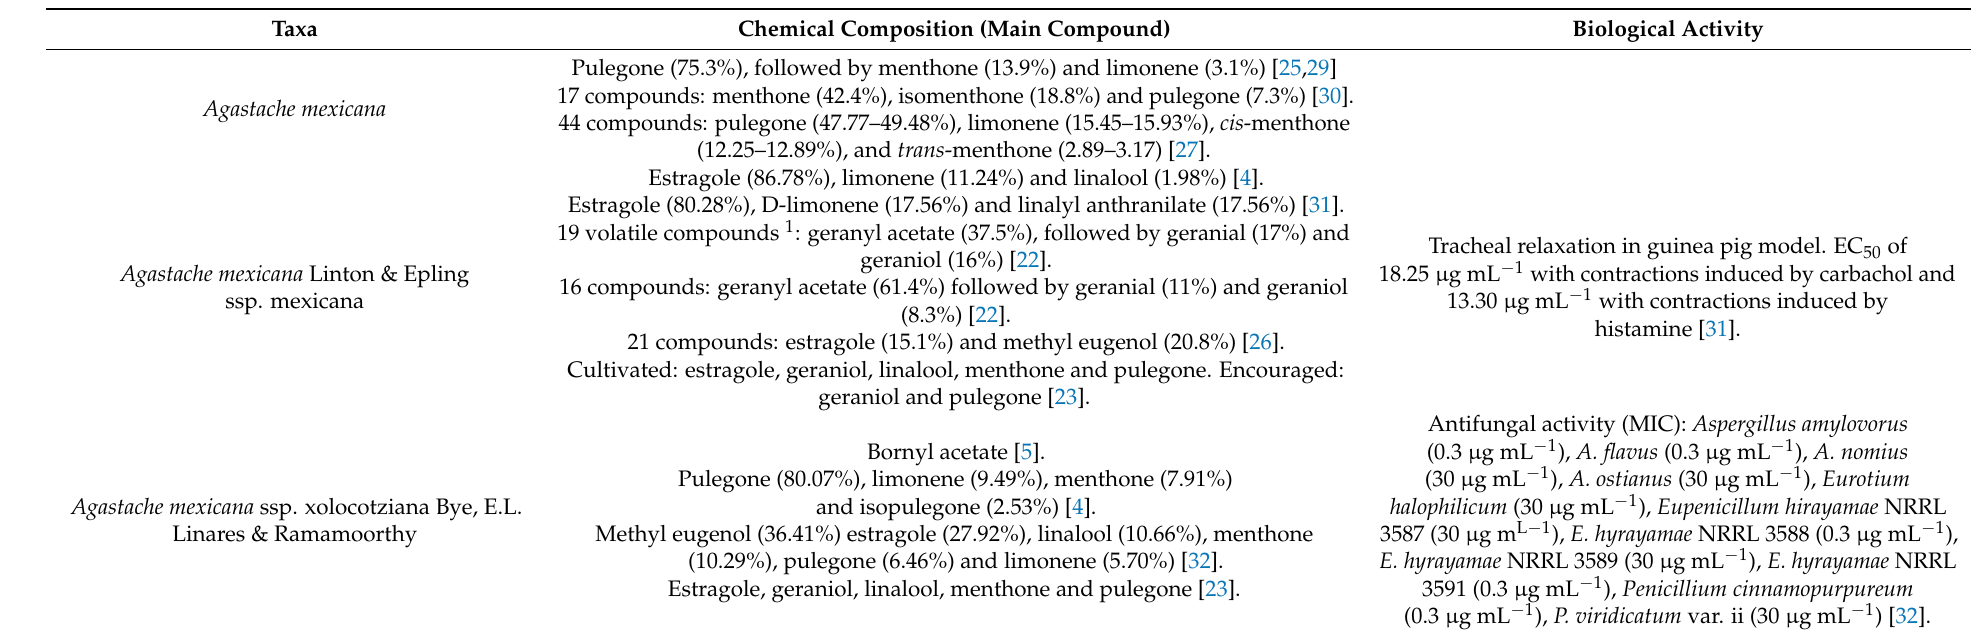
Table 1. Composition and bioactivity of essential oils from aerial parts of Agastache mexicana .